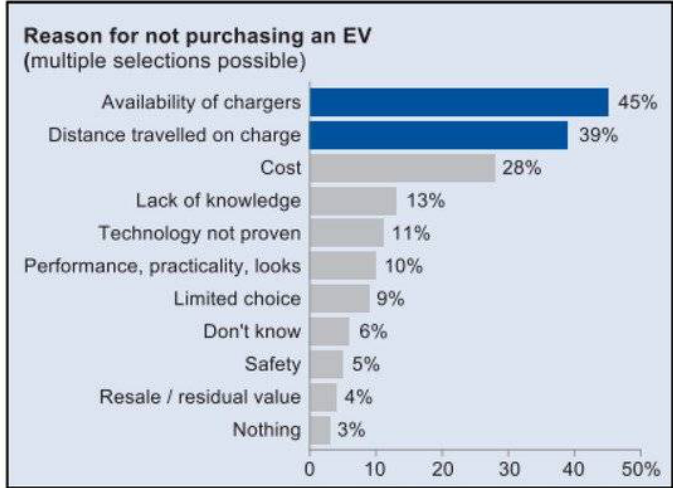
Figure 17. Top reasons why people do not buy an electric vehicle [76].